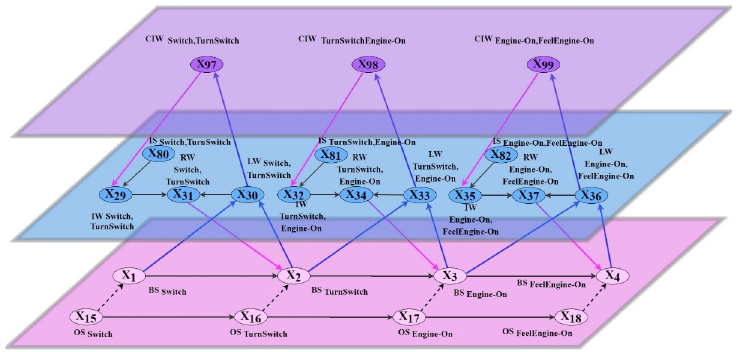
Fig 2. Connectivity for part of the second-order adaptive network